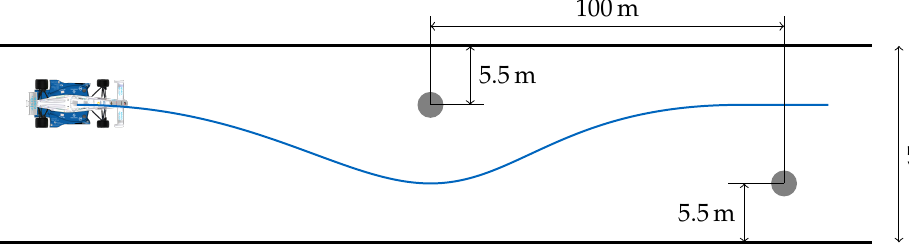
Figure 9. Evasion scenario with two obstacles (gray) on the backstretch of the LVMS (not to scale).